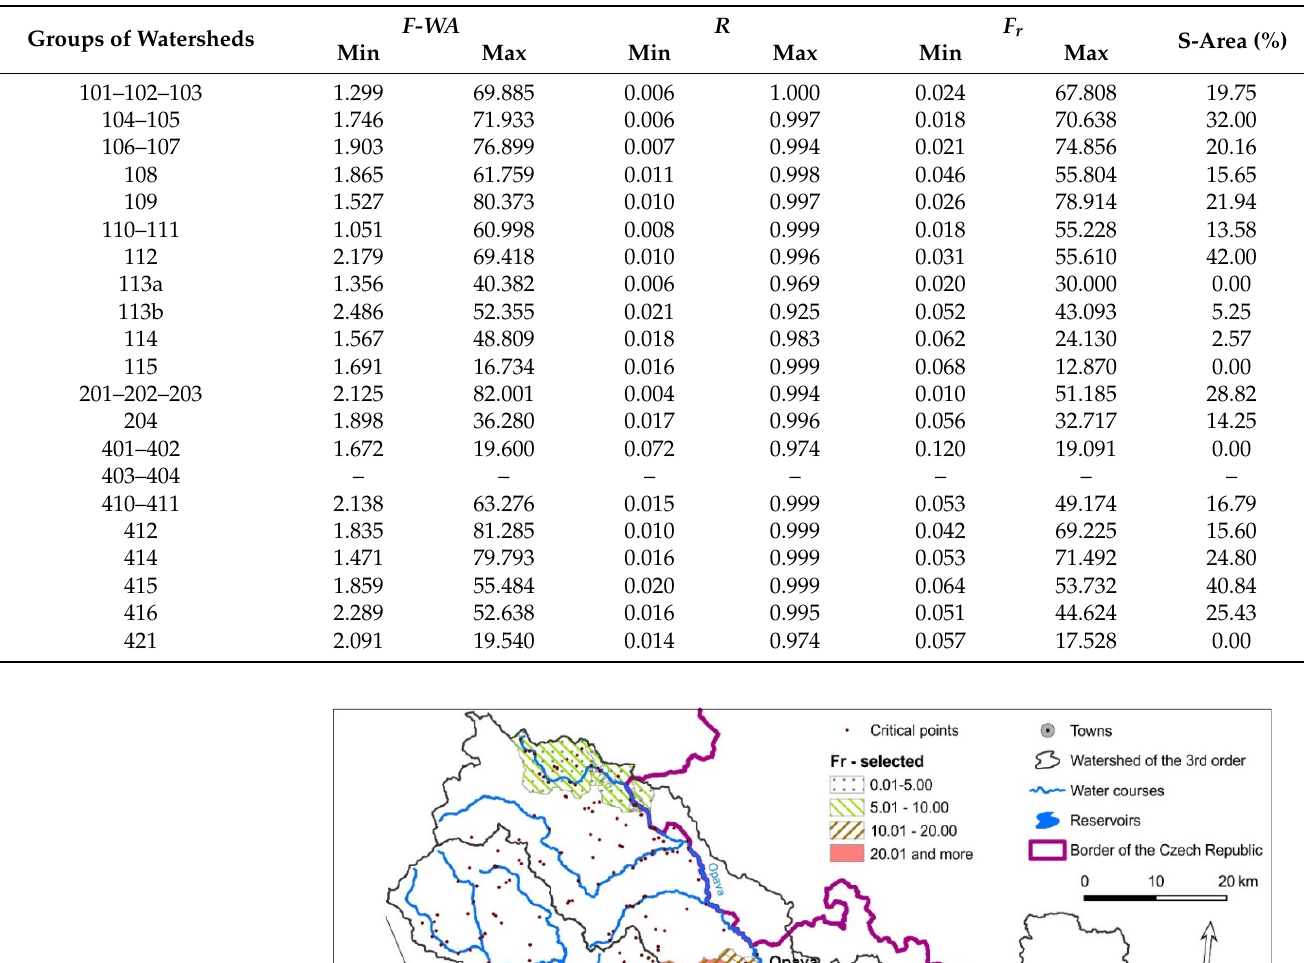
Table 4. Overall results of selected variables for the Czech Republic (min. and max. are the lowest and the highest recorded values, respectively, of the respective variable in a group of watersheds).